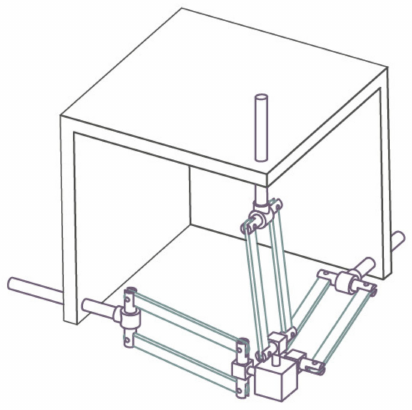
Figure 2. 3PRPaR mechanism diagram.